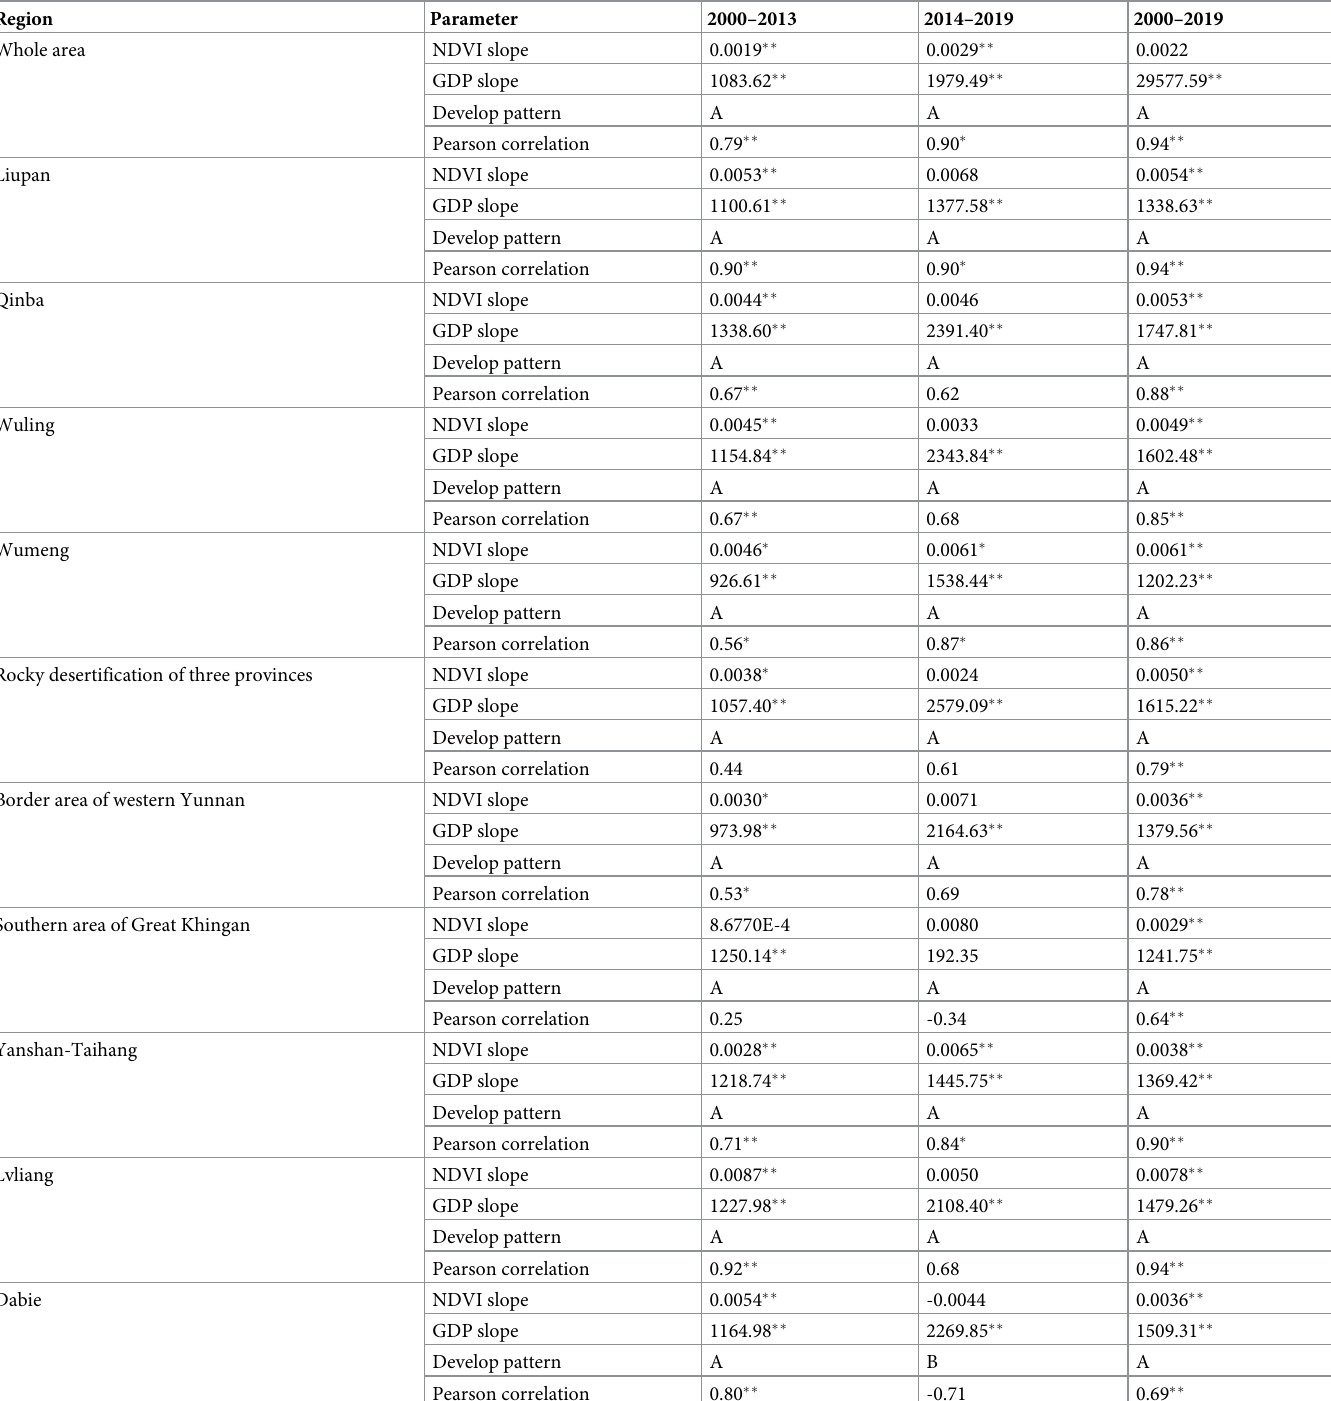
Table 3. Pearson correlation and development pattern between NDVI and GDP per capita in the fourteen contiguous areas of dire.